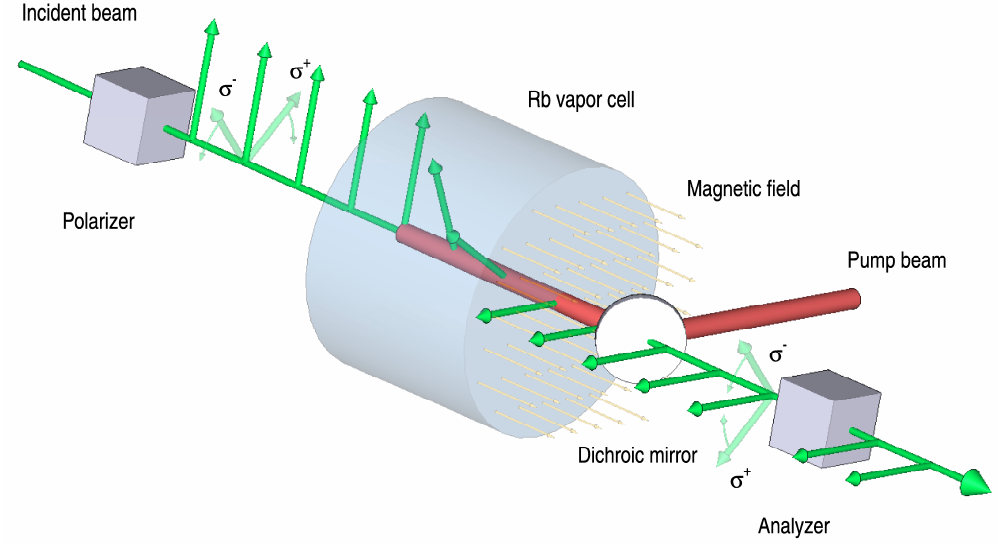
Figure 6. Schematic drawing of an ESFADOF consisting of an atomic vapor cell placed between two crossed polarizers. Due to the presence of the magnetic field, left and right circularly polarized light, σ - and σ + , experience different dispersion in the vicinity of the atomic absorption lines. This results in a significant phase difference between the two polarization components. Therefore, a wavelength dependent rotation of the polarization occurs. The second polarizer projects the rotated polarization onto its basis rotated by 90° with respect to the first one. Therefore an ESFADOF delivers in addition a suppression of